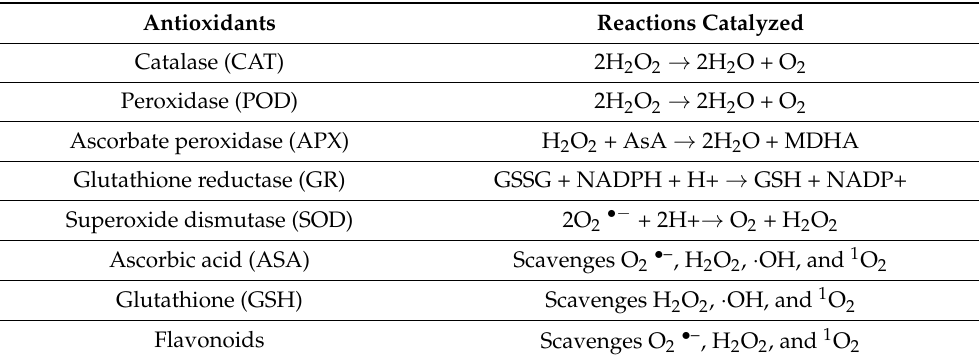
Table 2. Reaction mechanisms of major reactive oxygen species (ROS) scavenging enzymatic and non-enzymatic